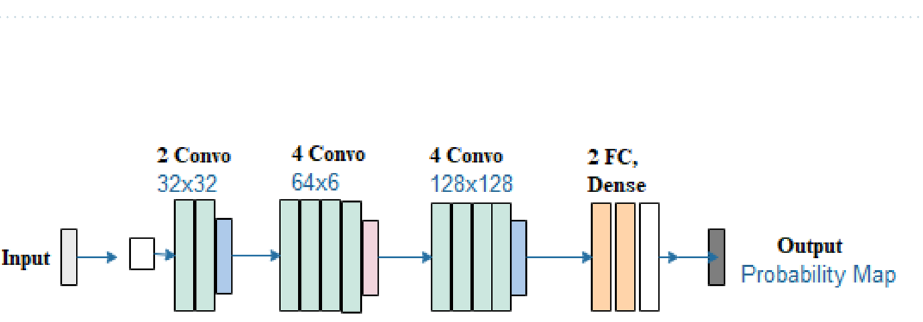
Figure 10. Plot of the accuracy and loss values for the training of the Top-1, 2, and 3 architectures respectively which were optimized using the EOSA-NAS model, showing their performances after sixty (60) training epoch.